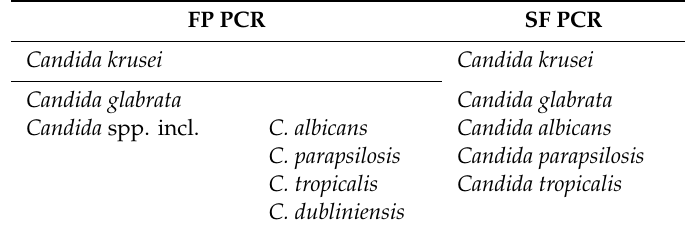
Table 1. Candida species covered by the molecular tests used in this